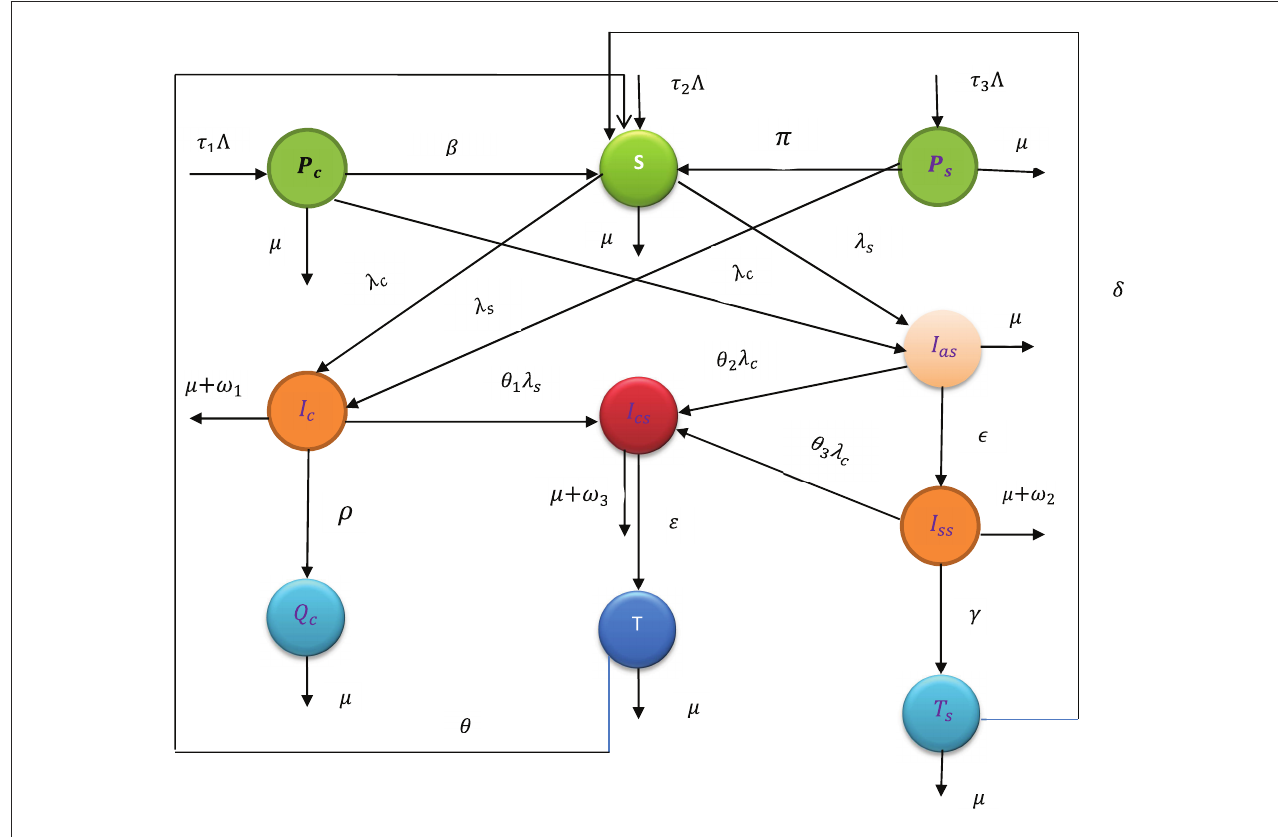
FIGURE1 Flowchart of the model (3) with forces of infections λ C and λ s as in (1) and (2),